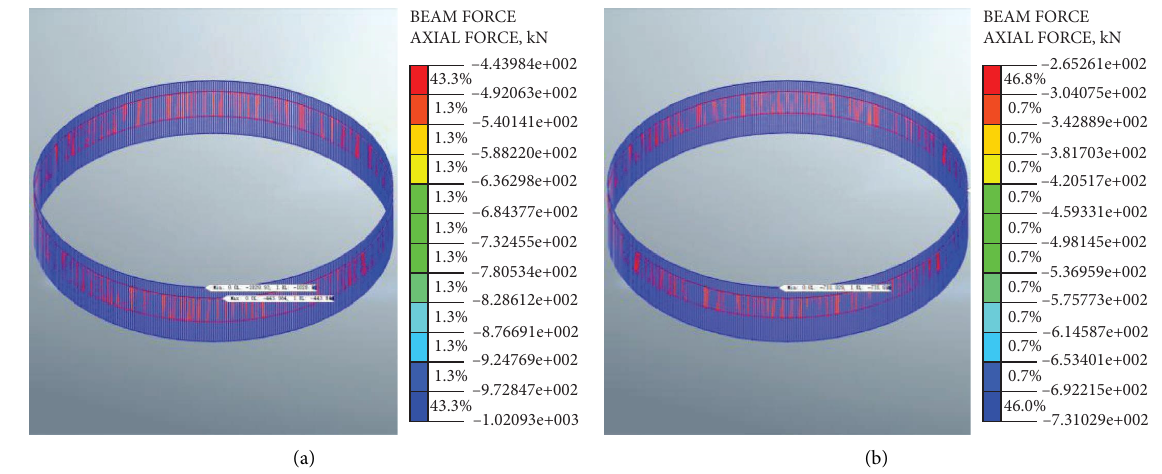
Figure 30: Working condition 3 lining axial force (a) without pore water pressure and (b) with pore water pressure applied.